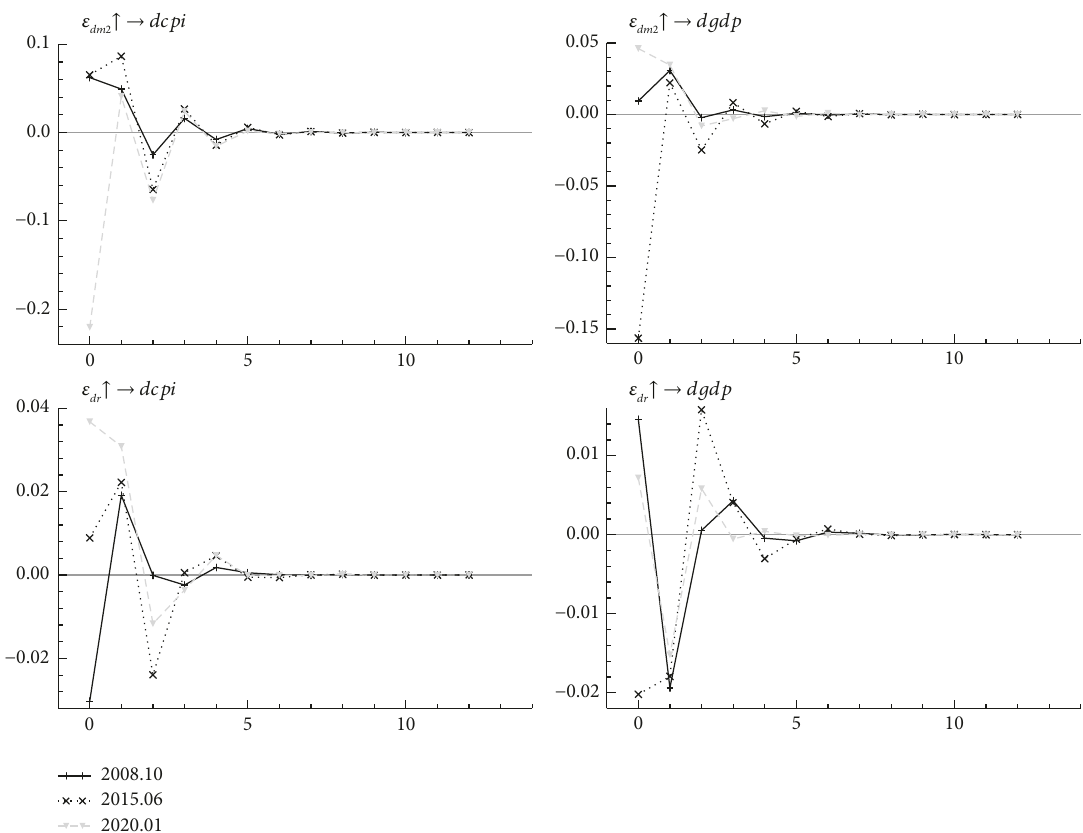
Figure 13: Impulse responses of monetary policy to macroeconomics at different time